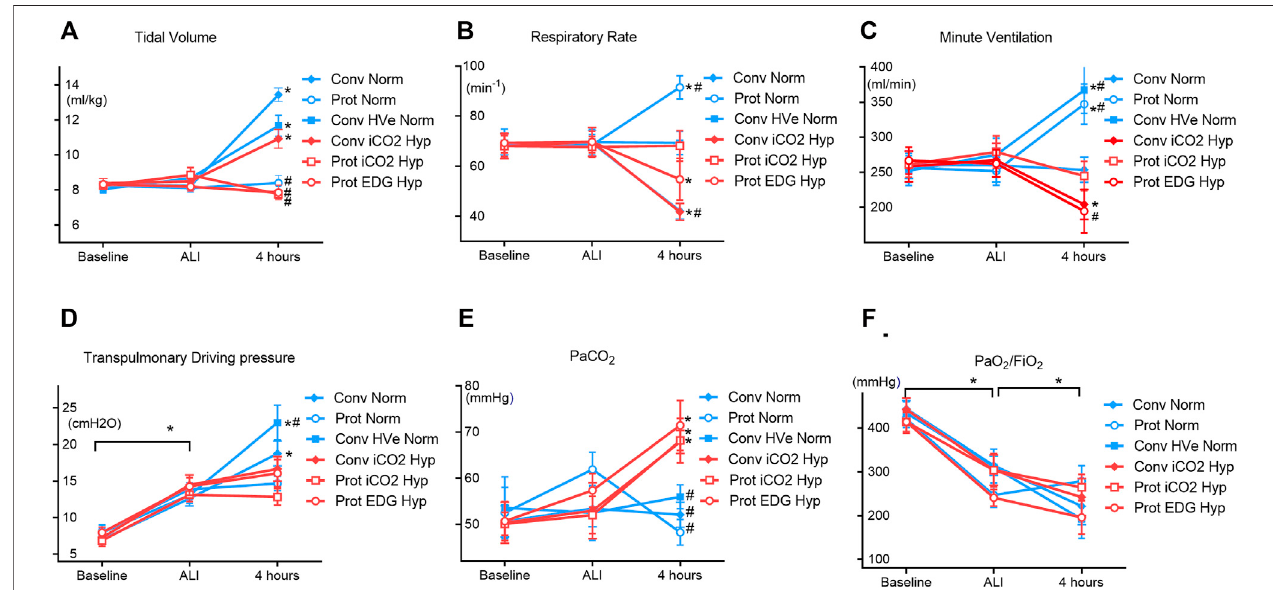
FIGURE1 | Physiologic dataat Baseline, ALI, and 4 h of ventilation (Mean ± SEM). Closed symbols: high tidalvolume; open symbols: lowtidalvolumes; blue color: normocapnia; red color: hypercapnia. * denotes signi fi cant differences between groups.